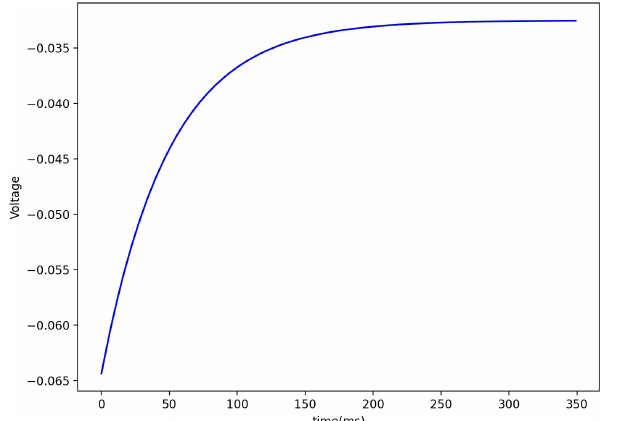
Figure 7. The potential graph of the neuron when the neuron with input and output is stimulated for 350